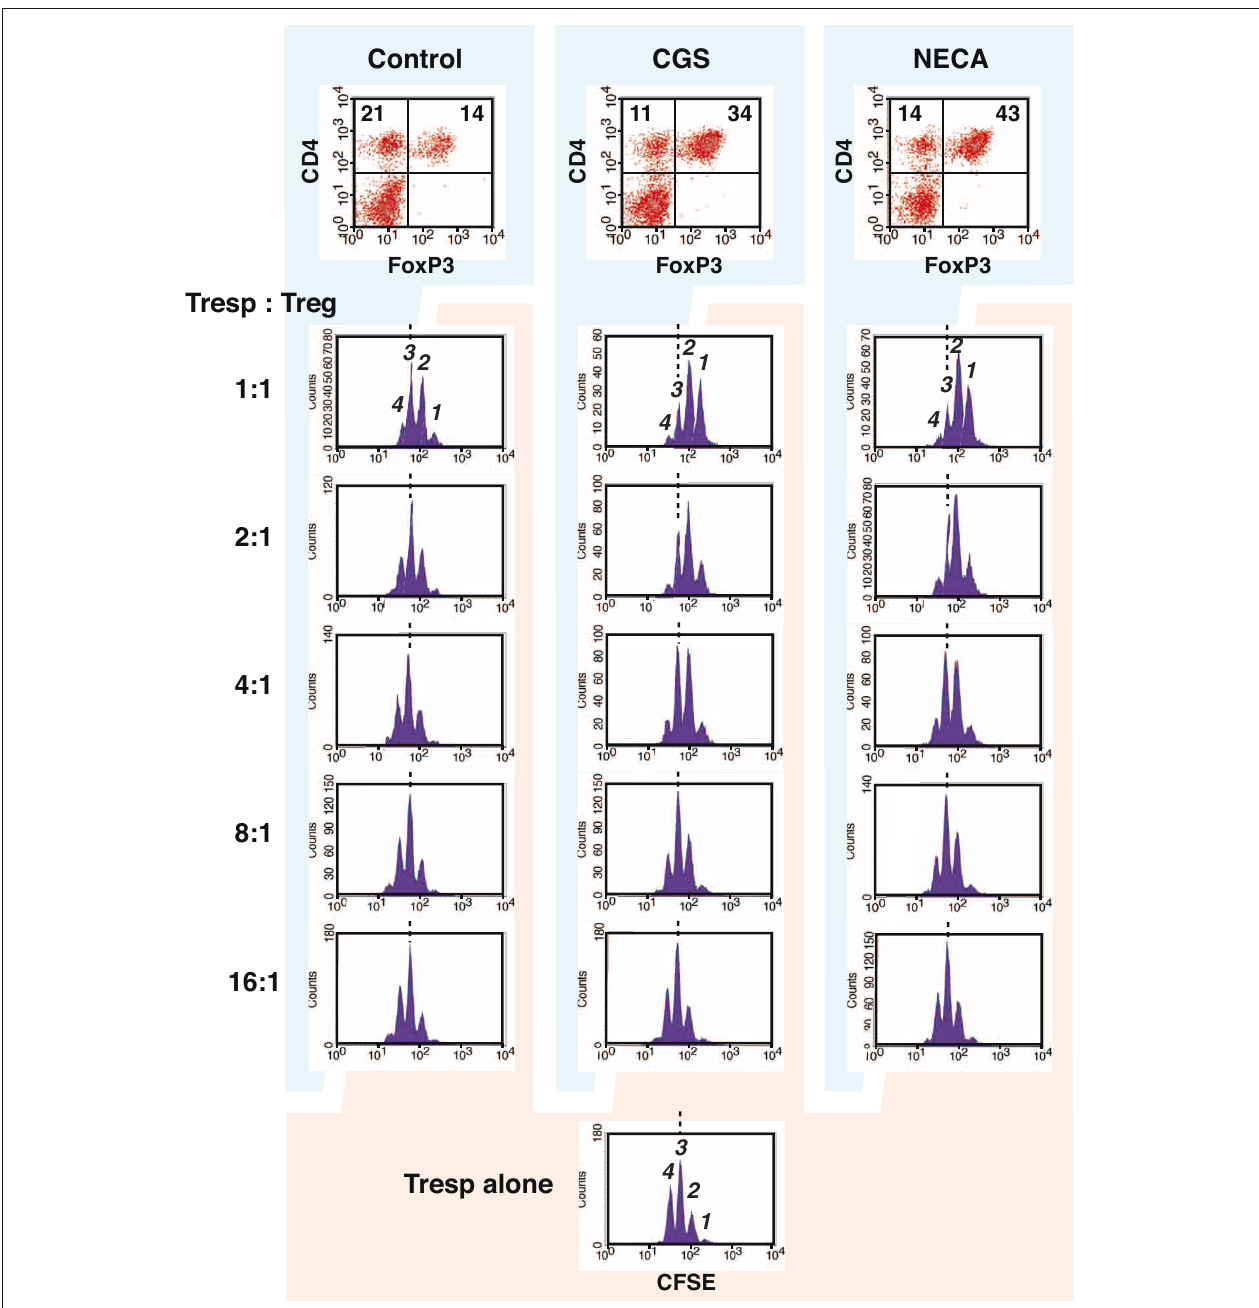
were co-cultured with the product of MLC, which contains Treg. Tresp:Treg in the figure is the ratio of CD4 + cells in Tresp to CD4 + FoxP3 + cells in the MLC. The extent of CD4 + Tresp cell proliferation was analyzed 2 days after the stimulation with anti-CD3mAb. The histograms were gated for Thy1.1 + CD4 + cells. Broken lines indicate the same peak (peak 3). The data shown here represent three separate experiments with similar